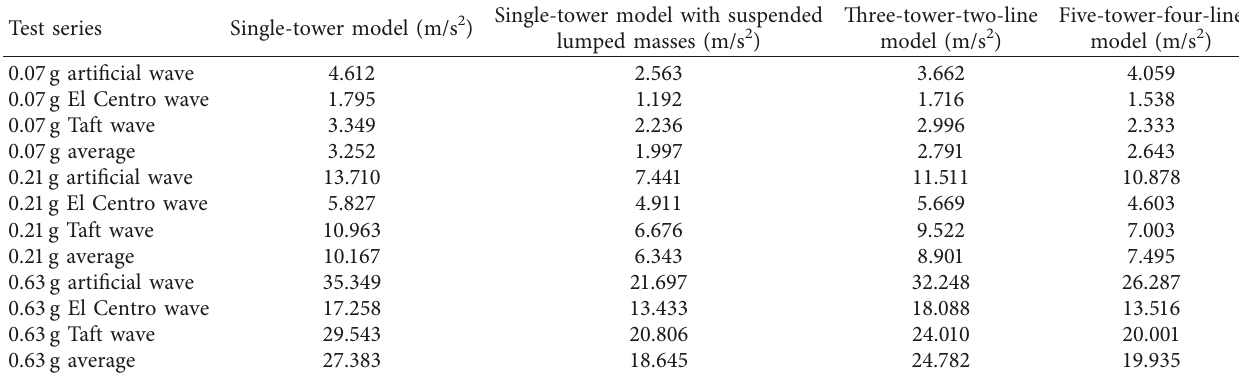
Figure 23: Transverse peak acceleration responses of the four counterweight models under a 0.21g artificial wave. Table 6: Vertical peak acceleration responses of the middle towers of the four